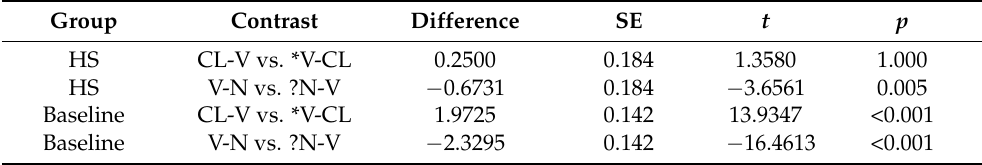
Table 7. Ratings in AJT: simple effects within